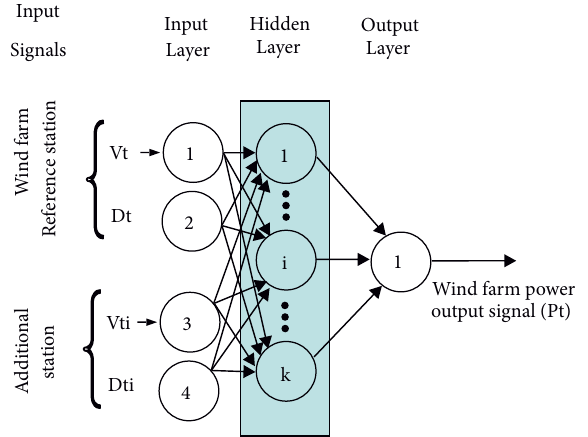
Figure 7: Schematic representation of the ANN of the ADWFPC model when the wind speed and direction data of a station other than the reference station of the wind farm are additionally incorporated.